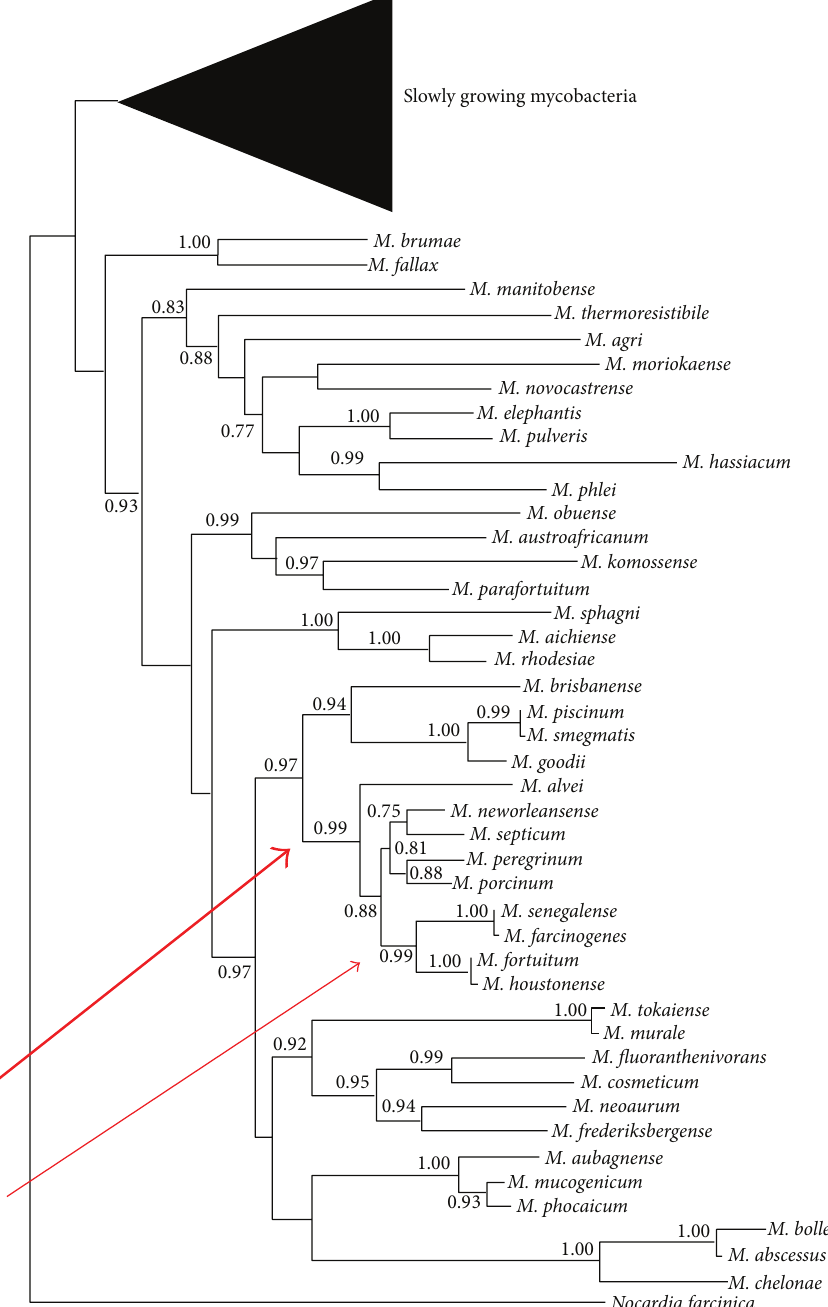
Figure 1: Estimate of mycobacterial phylogeny based on a multilocus seven-gene concatenate (hsp65, rpoB, 16S rRNA, smpB, sodA, tmRNA, and tuf) showing the position of Mycobacterium farcinogenes and M. senegalense within a branch that accommodates the rapidly growing nonphotochromogenic mycobacteria (thick arrow) and their close relationship to M. houstonense and M. fortuitum (thin arrow). The percentages of bootstrap values are shown next to the nodes. The tree was modified from Mignard and Flandrois